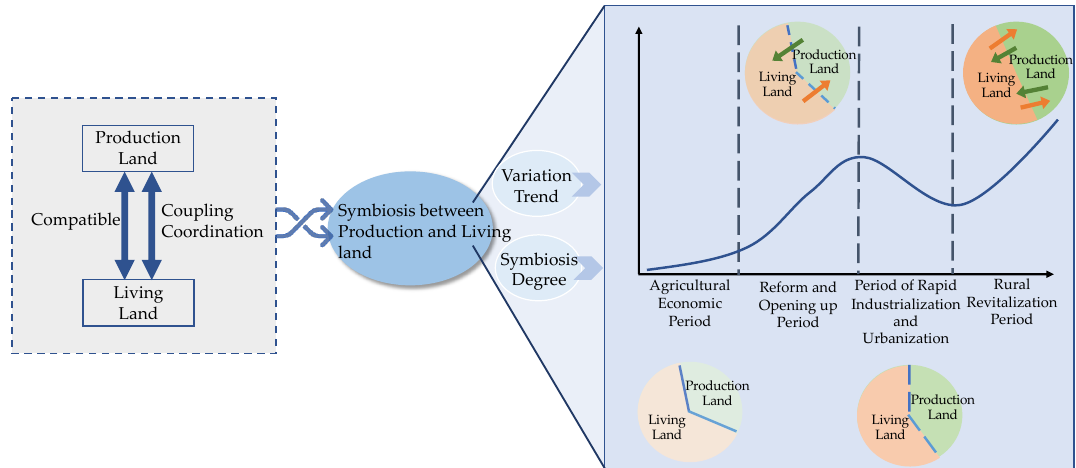
Figure 1. Analytical